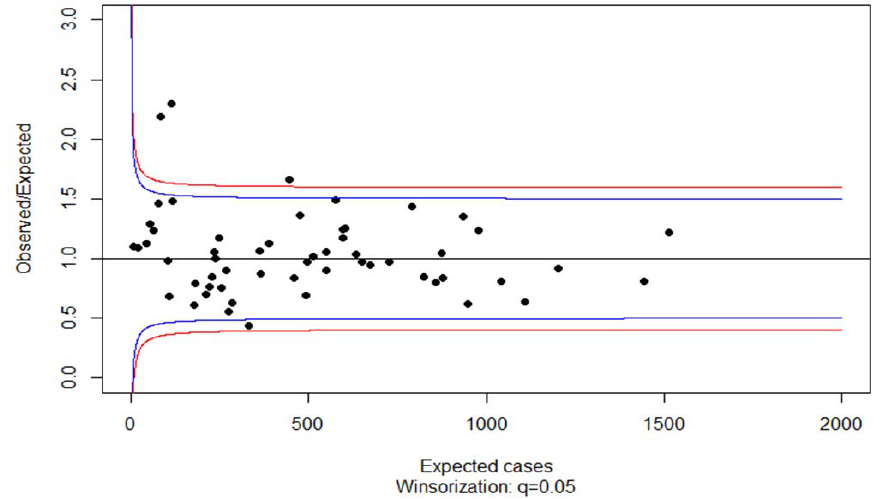
Figure 3. Standardized ratio of third level medication in neurologists and psychiatrists in the German federal state of Saarland. Additive adjusted funnel plot with band limits at 95% (blue lines) and 98% (red lines).